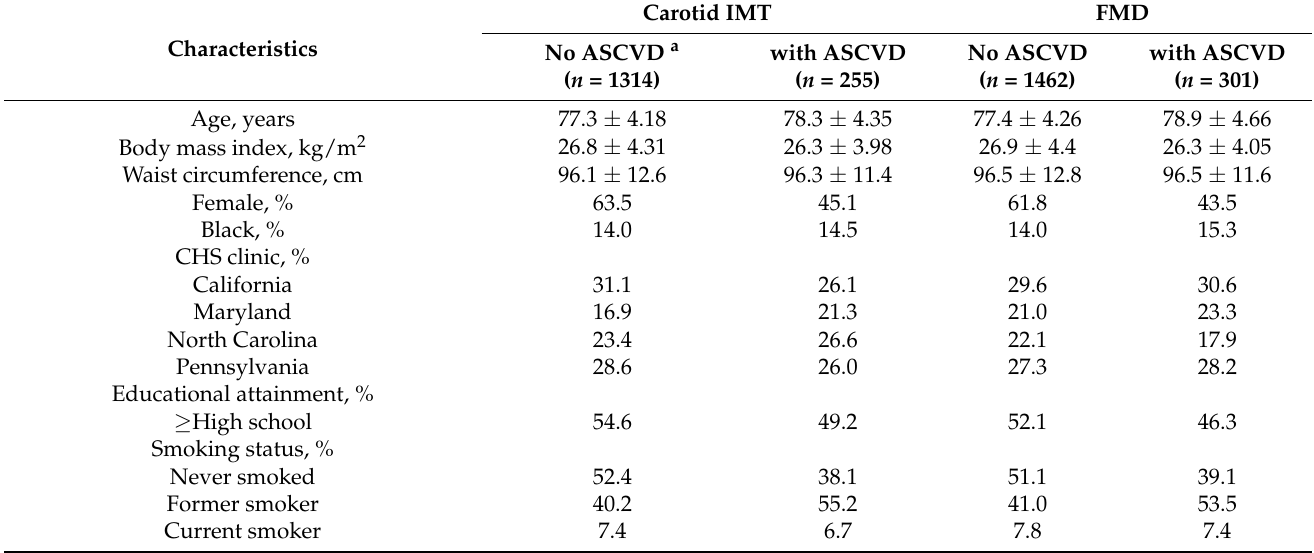
Table 1. Baseline (1996–1997) characteristics of participants in the Cardiovascular Health Study cohort.